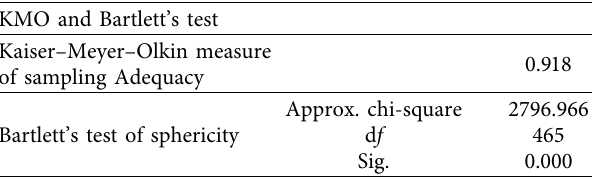
Table 5: Validity analysis of